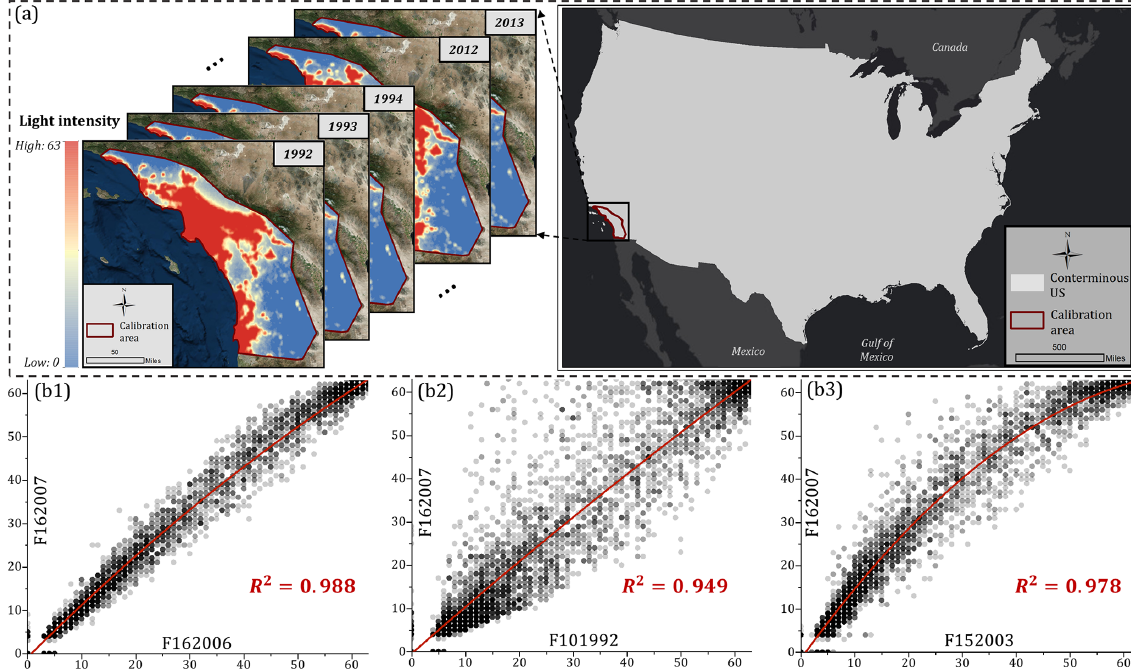
Figure 3. (a) DMSP/OLS NTL intercalibration in the Los Angeles metropolitan area and the city of San Diego; (b1) correlation between F162006 and reference year F162007; (b2) correlation between F101992 and reference year F162007; (b3) correlation between F152003 and reference year F162007. Basemap sources: Esri, HERE, Garmin, OpenStreetMap contributors, and the GIS user community. © Open- StreetMap contributors 2019. Distributed under a Creative Commons BY-SA License.